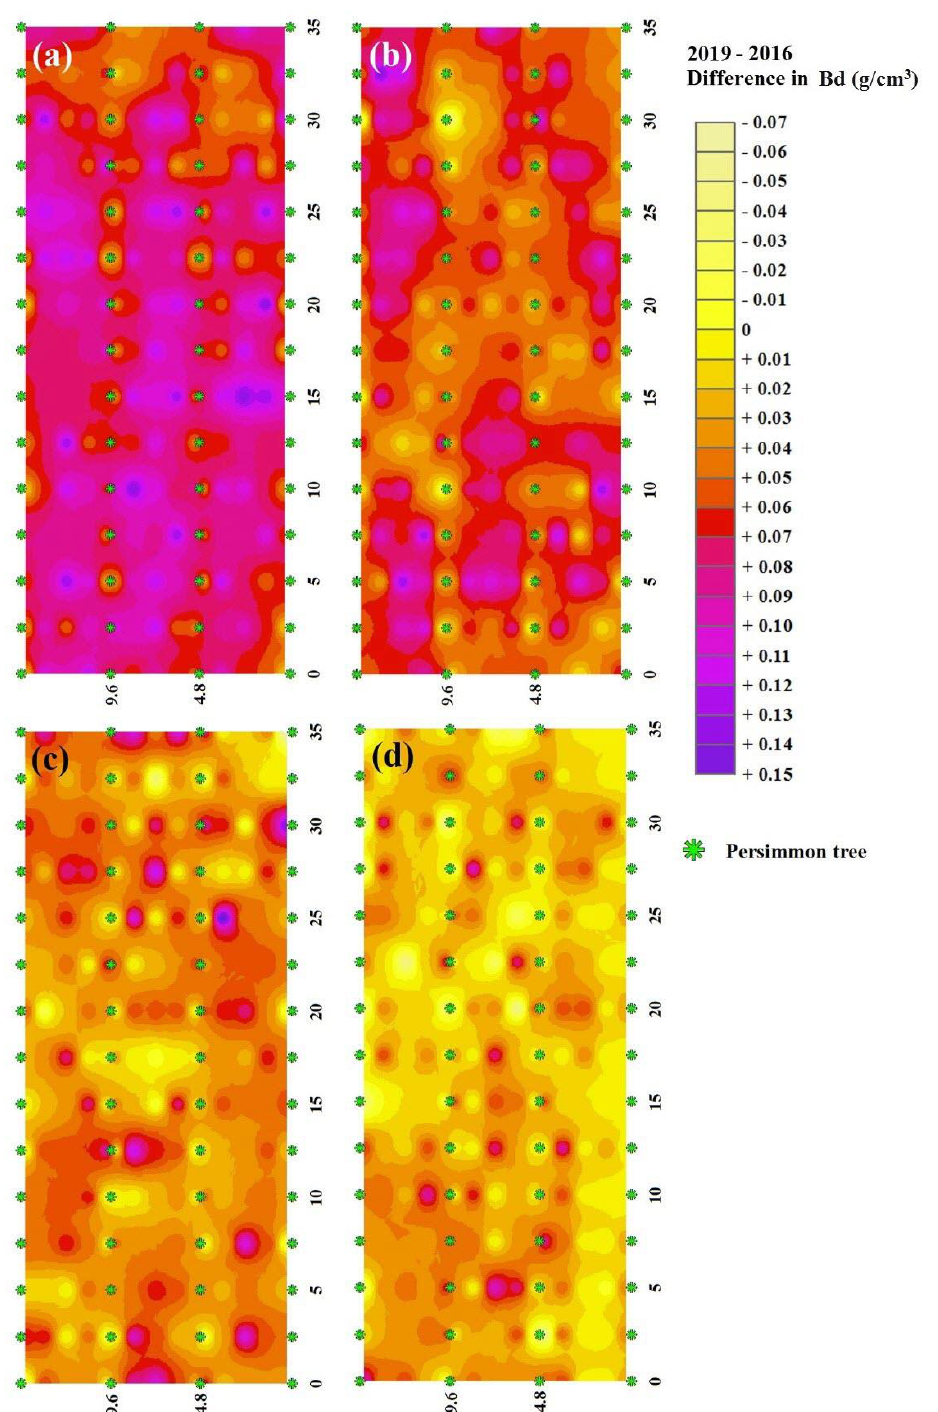
Figure 6. Bd di ff erences between 2016 and 2019 at four depths: ( a ) 0–6 cm, ( b ) 6–12 cm, ( c ) 12–18 cm Figure 6. Bd differences between 2016 and 2019 at four depths: ( a ) 0 – 6 cm, ( b ) 6 – 12 cm, ( c ) 12 – 18 cm and ( d ) 18–24 and ( d ) 18 – 24 cm.